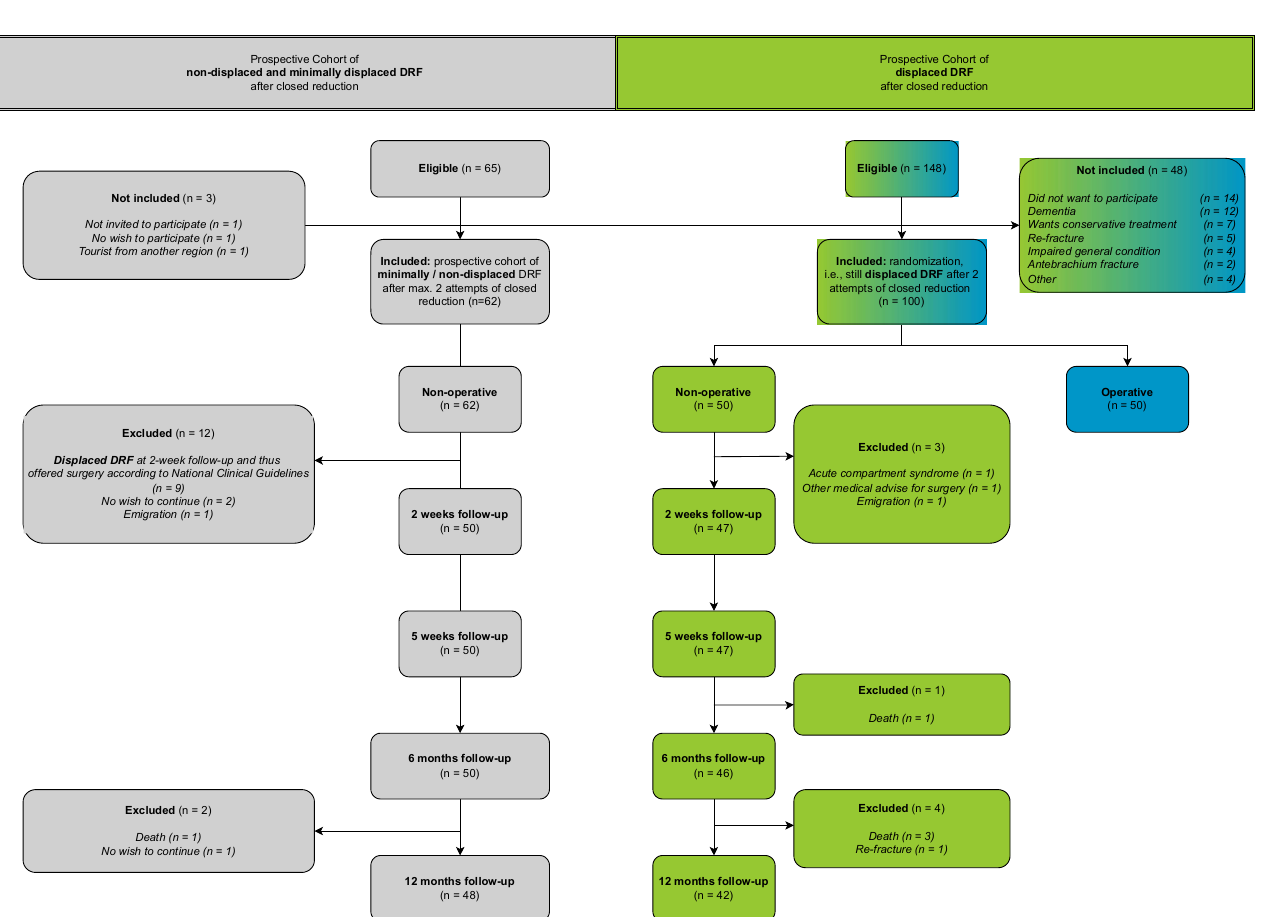
Figure 2. CONSORT flow diagram of the study including cohort 1 (minimally and non-displaced distal radius fractures) and cohort 2 (“non-operative” arm of the VOLCON randomized controlled trial). Numbers of eligible, included and excluded patients, as well as reasons for exclusion, are given. The eligible patients of the non-operative arm of the RCT had to consent to participate in the RCT in order to be included in the present study (green).